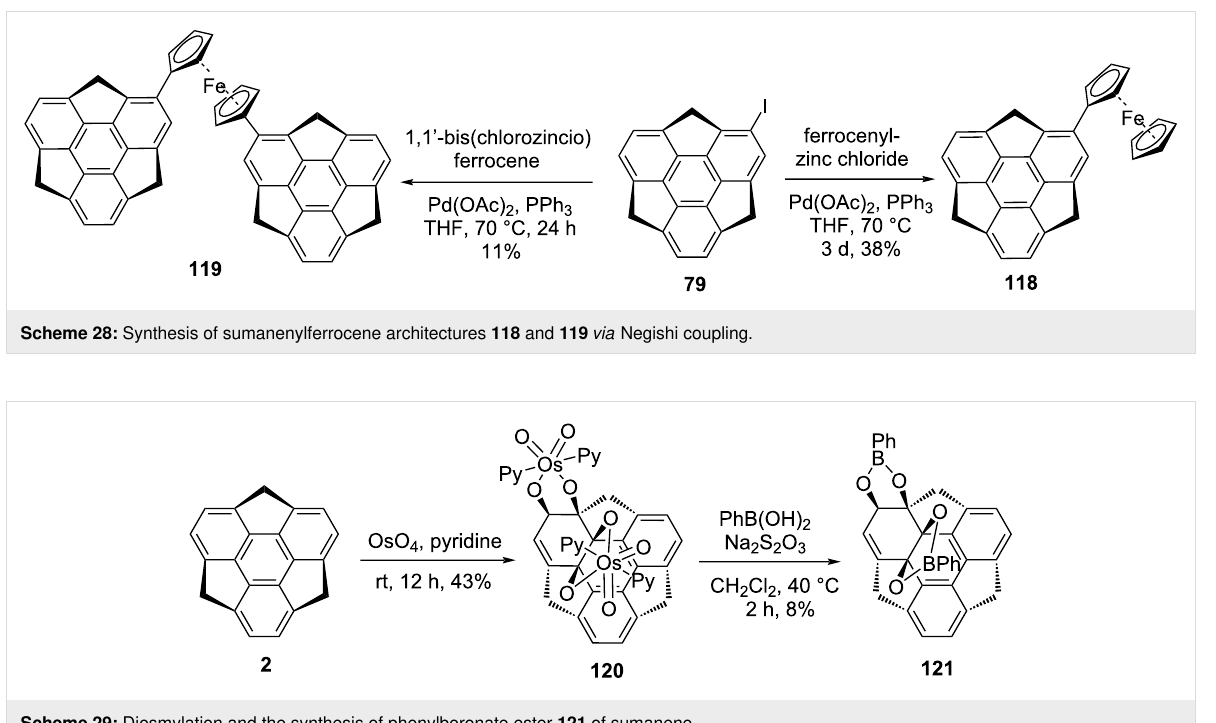
Scheme 29: Diosmylation and the synthesis of phenylboronate ester 121 of sumanene.